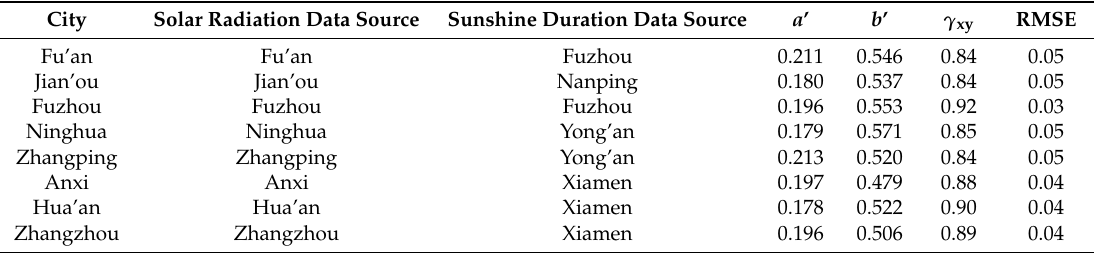
Table 3. Linear regression analysis of clearness index and sunshine duration fraction for eight cities.